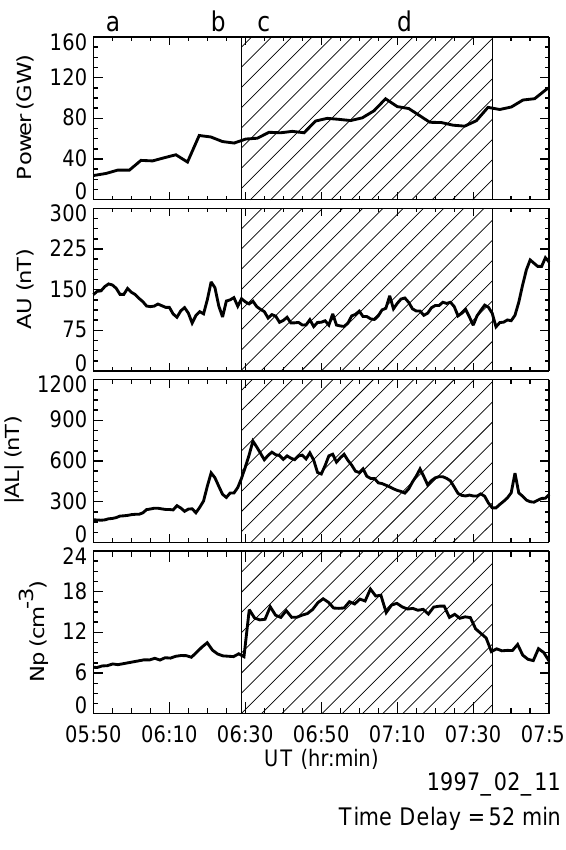
Fig. 2. Variations of the AU and | AL | indices, the solar wind density, N p , and the auroral power during the period of 05:50– 07:50UT, 11 February 1997. The shaded area indicates the period of the major density enhancement. The labels a–d on the top of the power panel are referred to the auroral images shown in Fig.